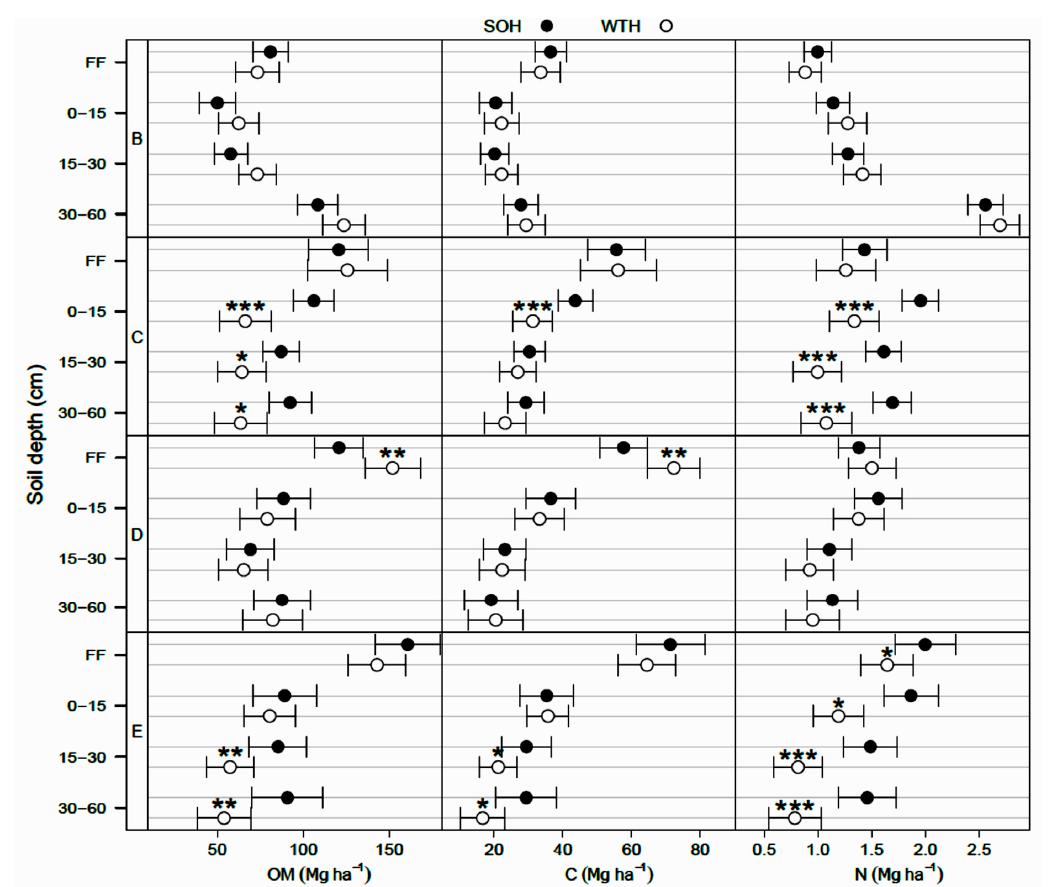
Figure 2. Soil organic matter (OM), organic carbon (C), and total nitrogen (N) pools as a function of depth, harvesting treatment (stem-only harvesting (SOH) and whole-tree harvesting (WTH)) in four soil provinces of Quebec: B = Appalachians; C = Laurentians; D = Abitibi Lowlands; E = Mistassini Highlands. FF = forest floor. Data presented are model-adjusted means ± 95% confidence intervals. Asterisks indicate significant differences between harvesting treatments within a given soil province: * p ≤ 0.05, ** p ≤ 0.01, *** p ≤ 0.001.